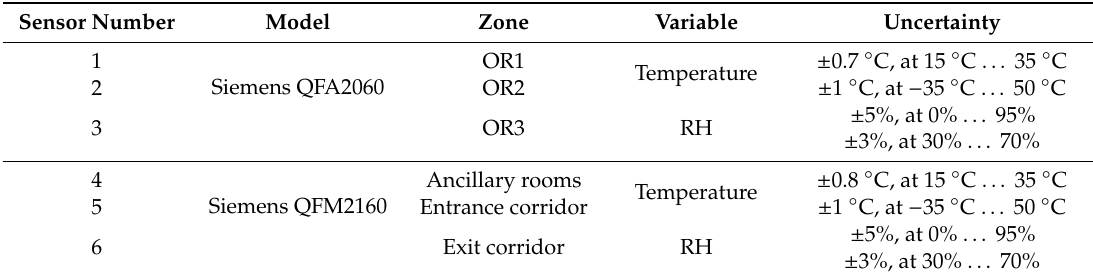
Table 2. Temperature and relative humidity (RH) sensors.